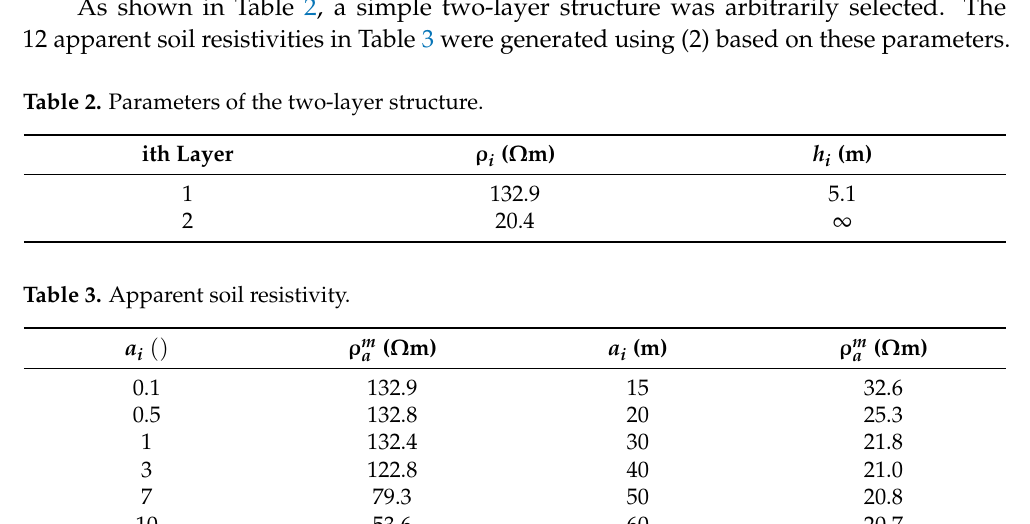
Table 3. Apparent soil resistivity.